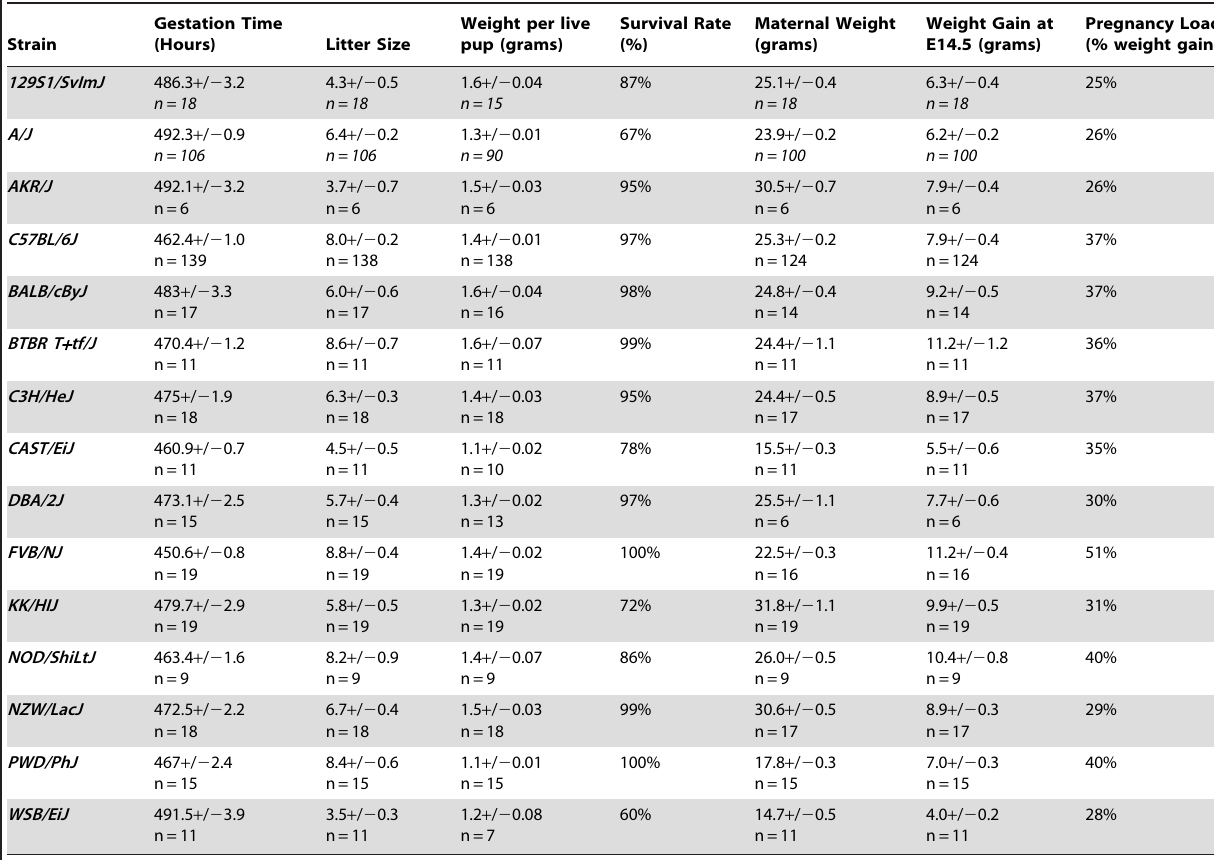
Table 1. Data summary from individual strain